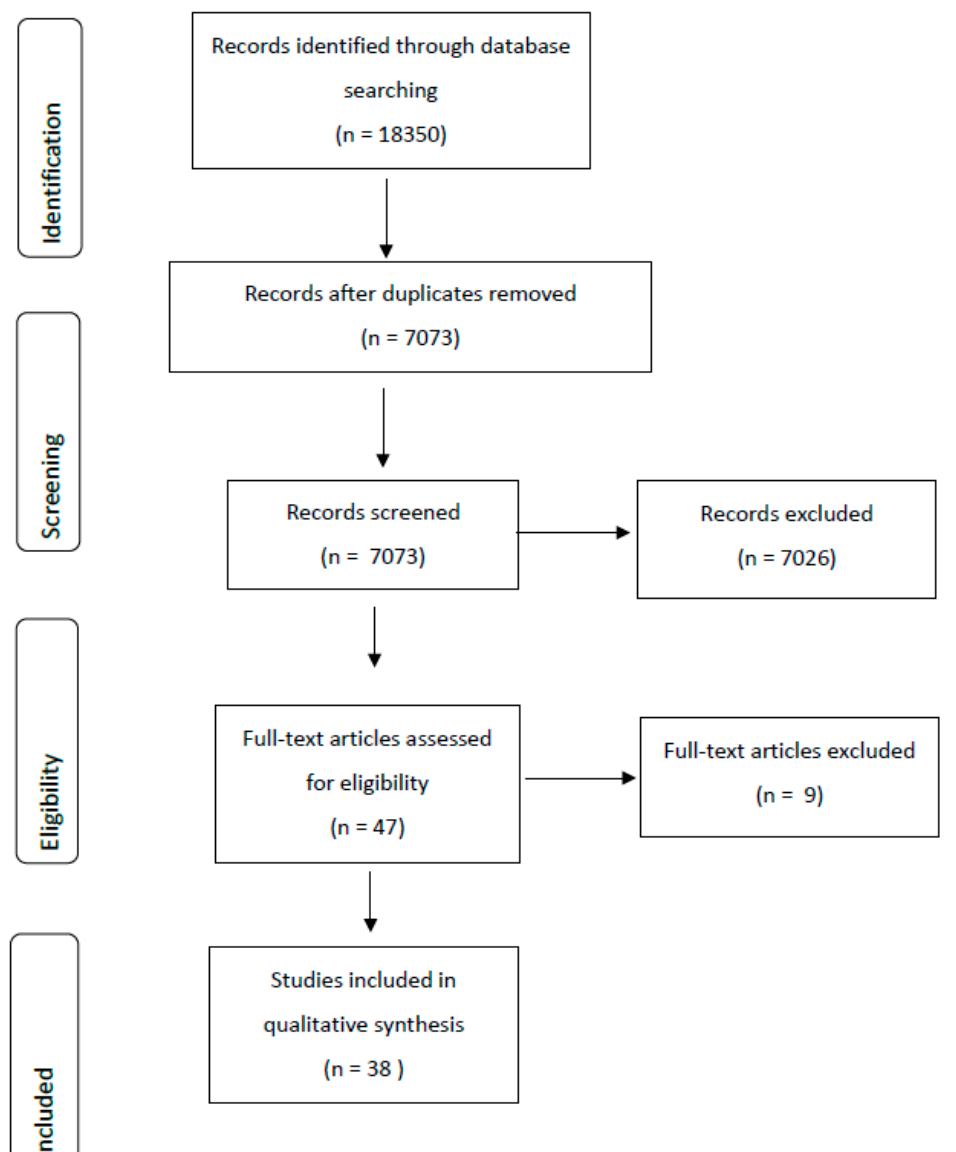
Figure 1. Summary of the literature search process.